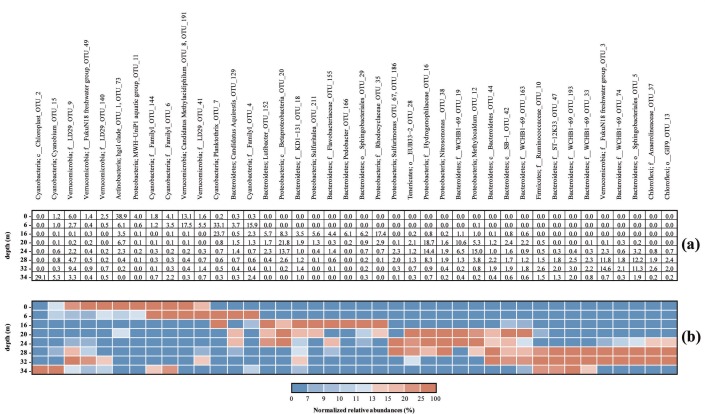
Relative abundance of the 40 most abundant bacterial genera along the Lake Averno water column.(A) Data are normalized to percent of total OTUs. (B) Table cells are colored (gradient scale from blue to red) according to the relative abundances. The abundance of each genus was normalized with respect to the average abundance. Hence, this allowed visualization of the relative increase or decrease in abundance of each genus at the 8 sampling depths, despite the differences in abundance between genera. In addition, the genera were clustered (the y-axis) to visualize by different shades of color those with similar patterns. Each group have both a broad group name (Phylum) and a specific name (Genus). If no genus name could be assigned, the best assignment is reported.